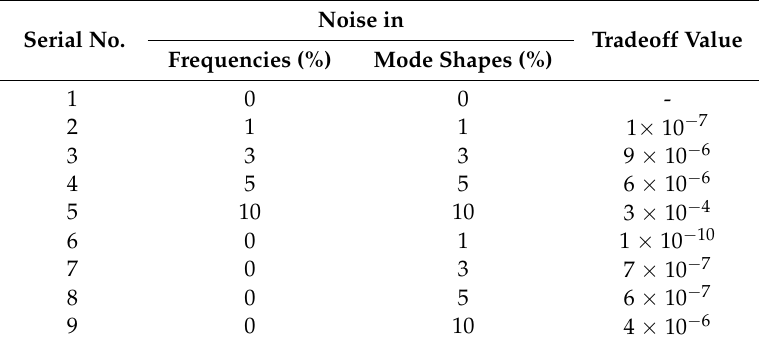
Figure 5. Typical Pareto front for Case 1 using Objective Function I with 5% noise both in frequencies and mode shapes. Table 1. Tradeoff value for Case 1 for all noises